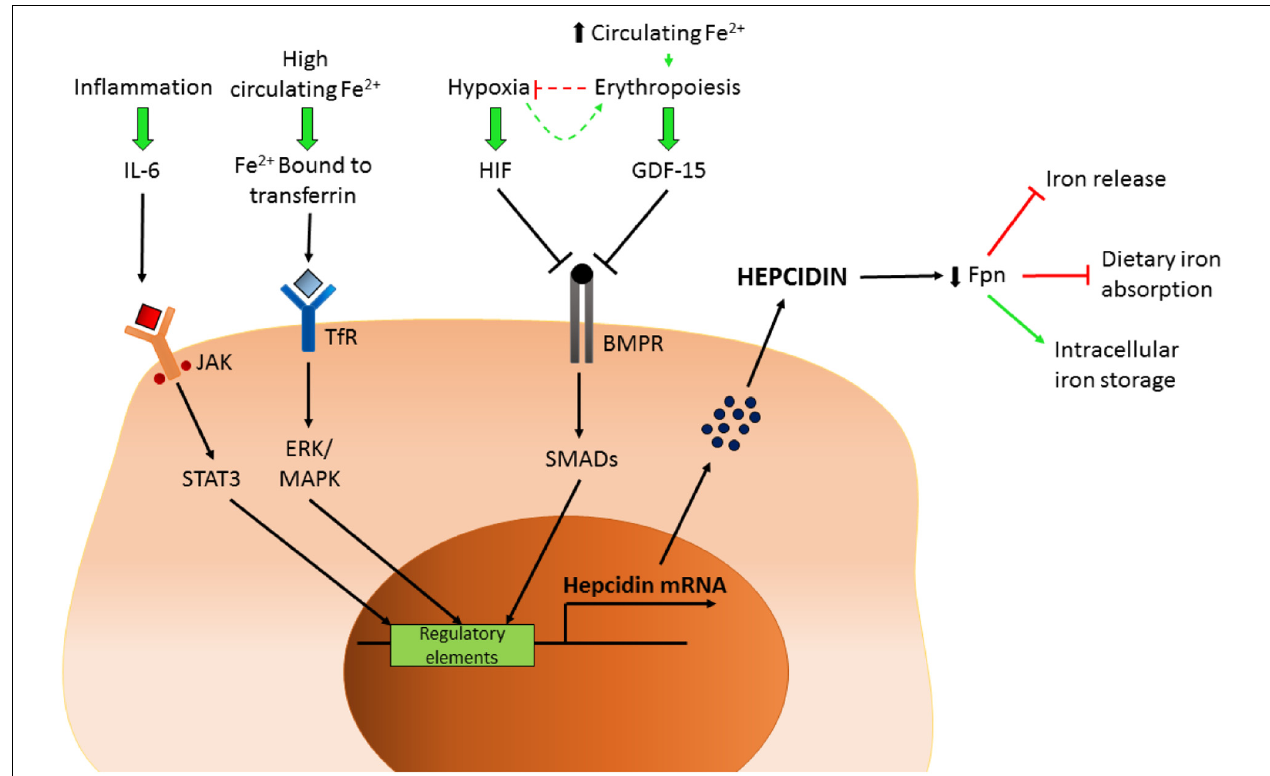
FIGURE 2 | Control of hepcidin expression. Schematic representation of the factors controlling hepcidin transcription. IL-6, interleukin 6; JAK/STAT3, Janus kinase/signal transducers and activator of transcription 3; Fe, iron; TfR, transferrin receptor; HIF, hypoxia-inducible factor; GDF-15, growth/differentiation factor 15; BMPR, bone morphogenetic protein receptor; Fpn,